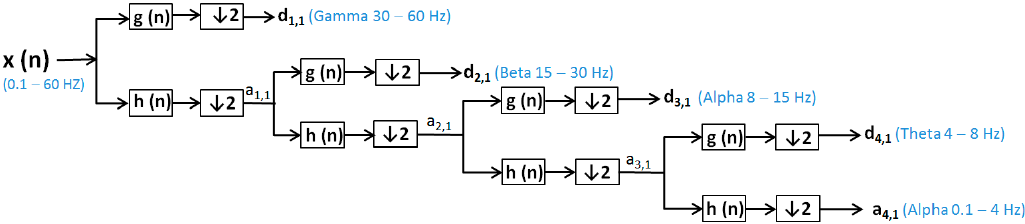
Figure 1. Electroencephalogram (EEG) from a patient with no seizure-signal filtering and decomposition using the discrete wavelet transform (DWT) method.